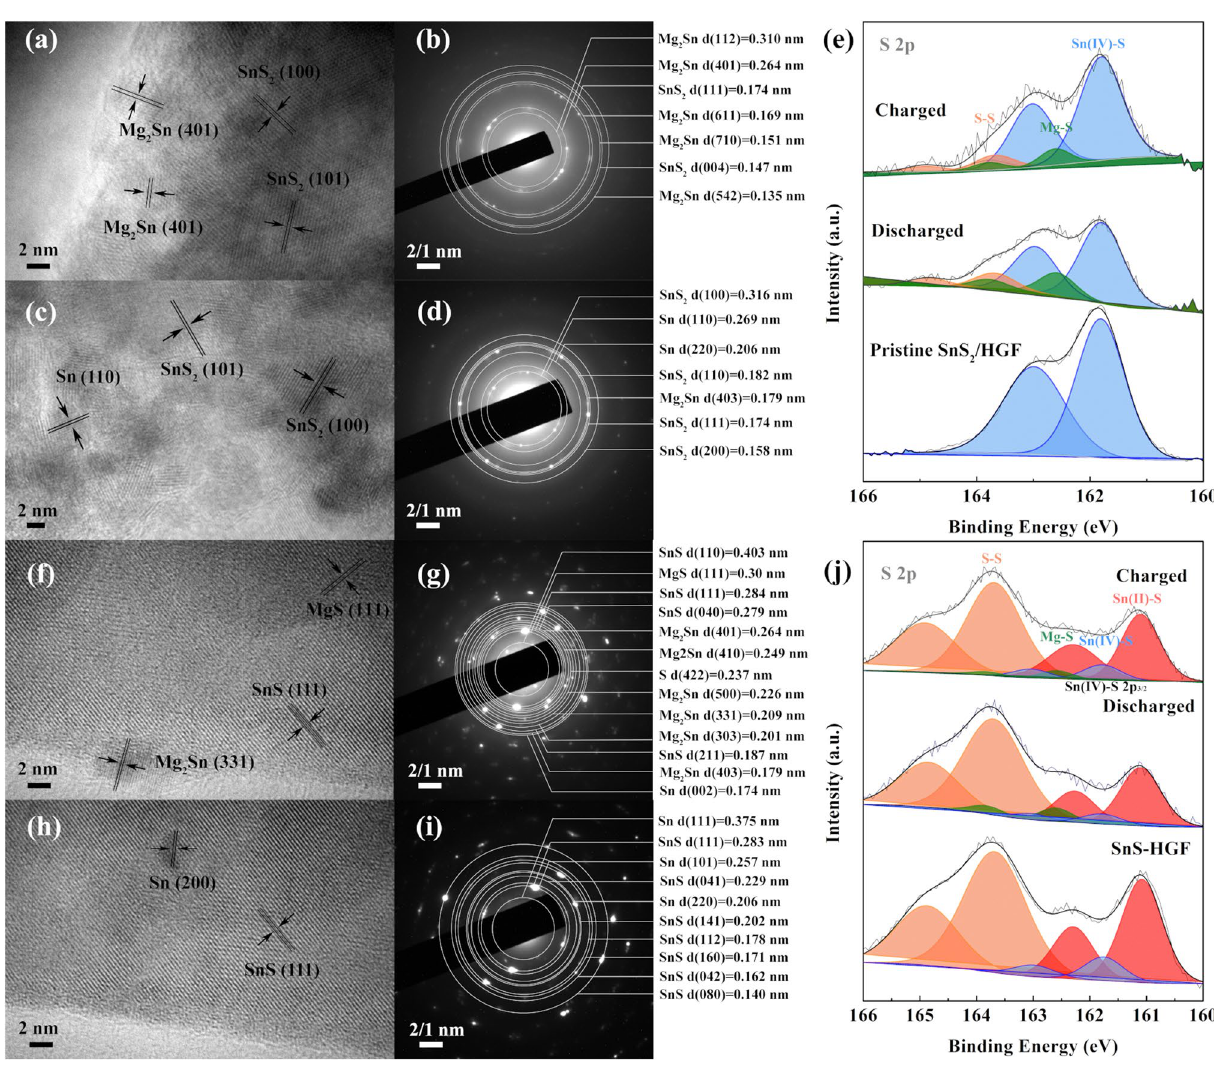
Fig. 6 Ex situ HRTEM images and corresponding SAED pattern in MIBs. a, b highly defective SnS 2 /HGF and f, g SnS/HGF after fully dis- charged to 0.01 V. c, d highly defective SnS 2 /HGF and h, i SnS/HGF after being charged back to 2.0 V. Ex situ XPS spectra represent valence changes of S 2 p of the e highly defective SnS 2 /HGF and j SnS/HGF after the first cycle at charged and discharged